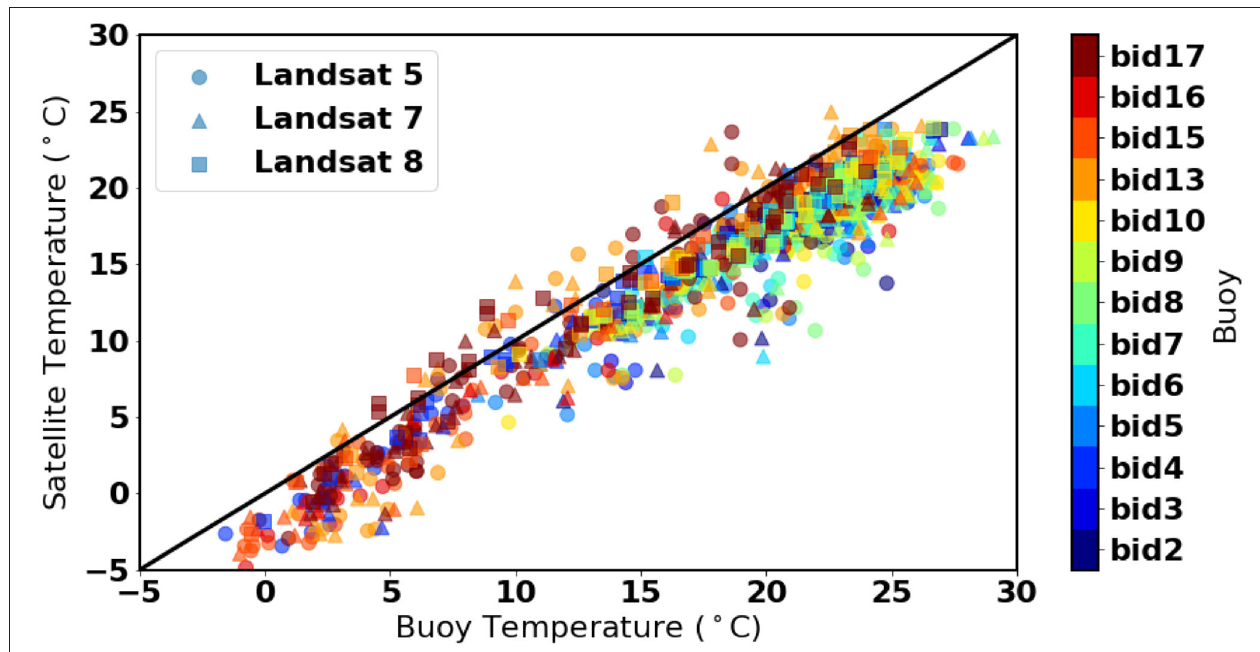
FIGURE 2 | Comparison between Landsat-derived temperature and surface in situ buoy measurements. The black line represents a 1:1 relationship for reference.